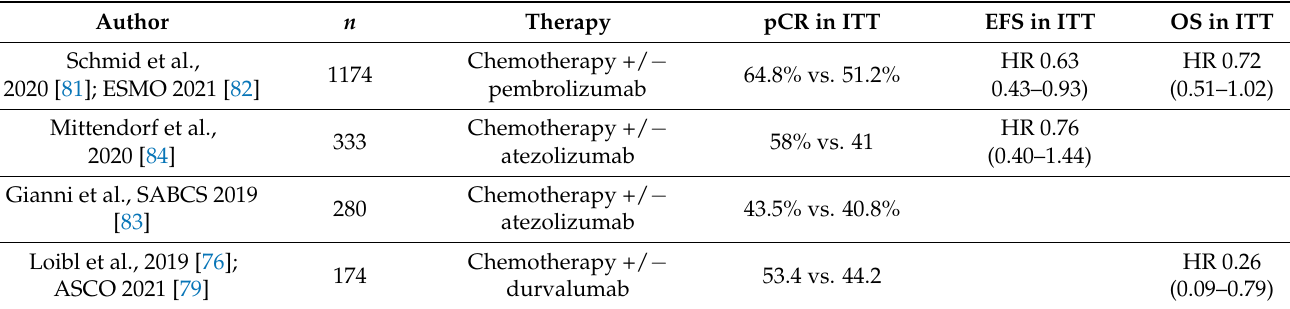
Table 4. Randomized evidence for ICPis in early triple-negative breast